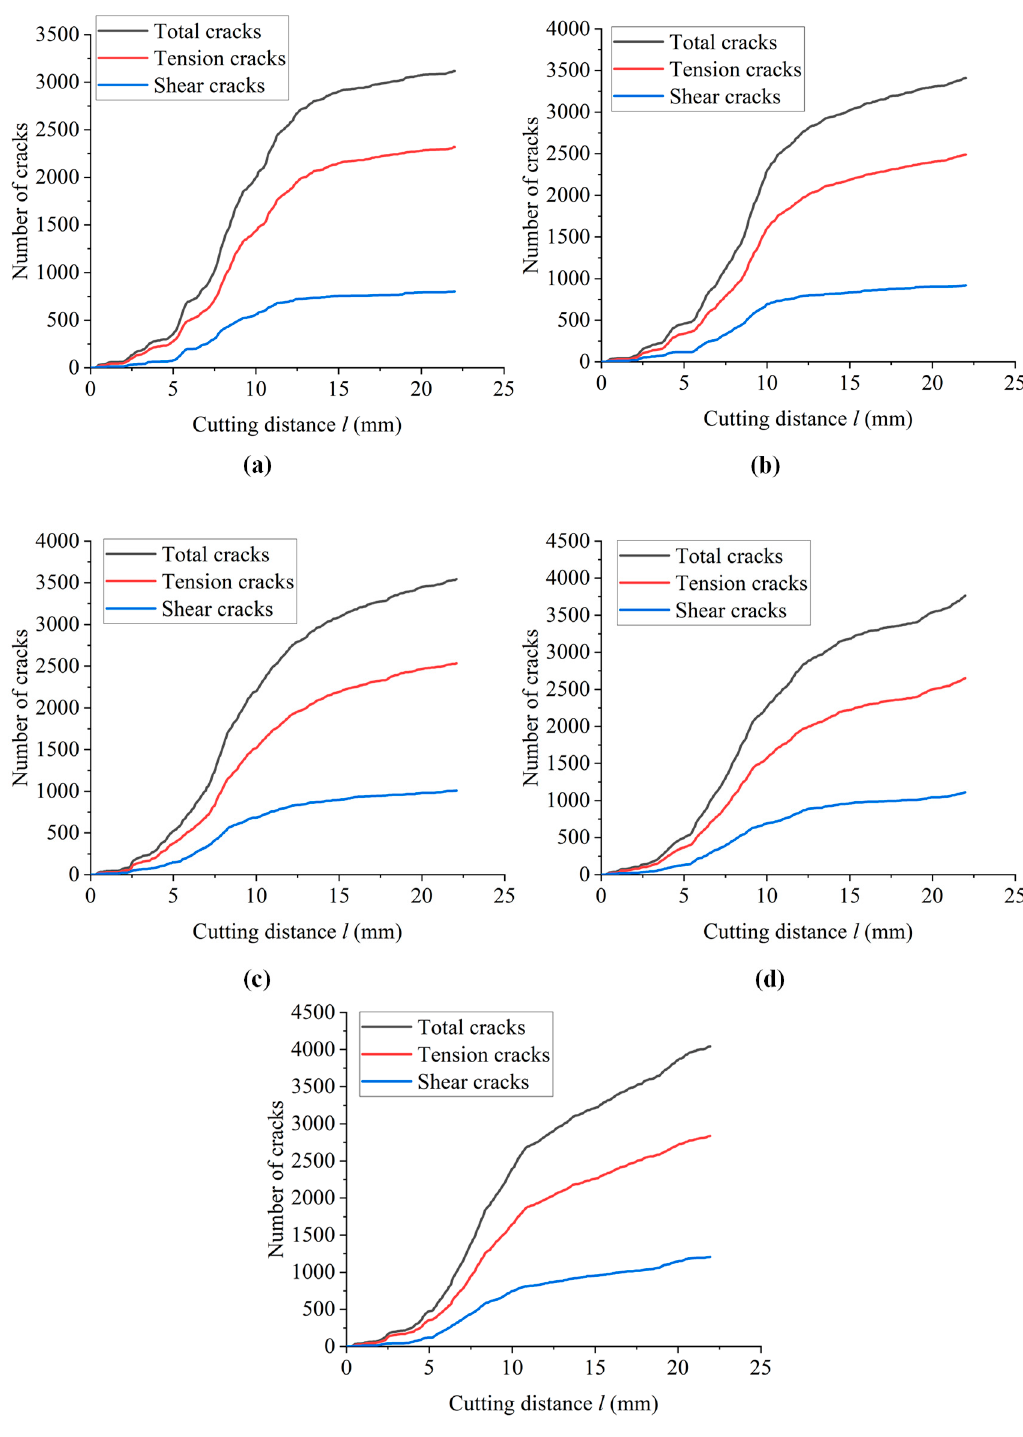
Figure 21. Variation characteristics of crack number of specimens with different cutting rates. ( a ) 6 m/s; ( b ) 7 m/s; ( c ) 8 m/s; ( d ) 9 m/s; ( e ) 10 m/s.